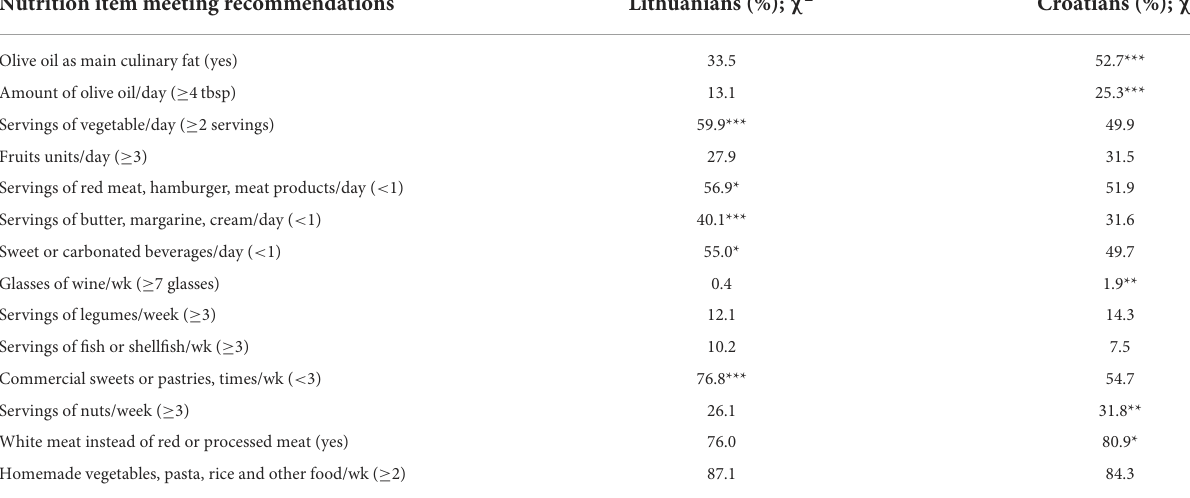
TABLE 2 The consumption of different food items among Lithuanians and Croatians university students.